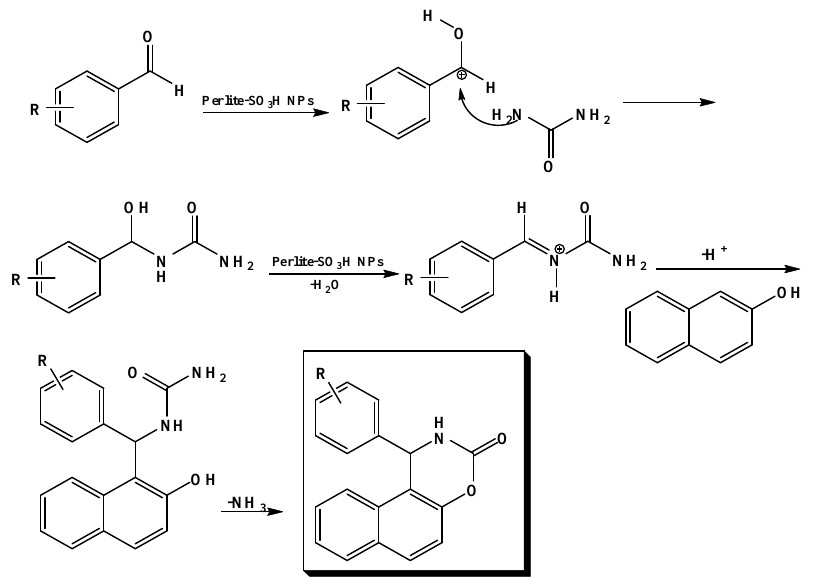
Scheme 3. A proposed mechanism for the synthesis of 2-dihydro-1-aryl-naphtho[1,2- e ][1,3]oxazine-3- one derivatives in the presence of perlite-SO